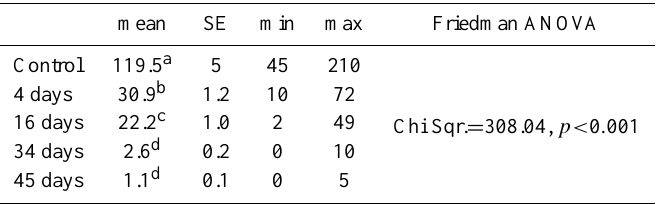
Table 1. Summary of Friedman ANOVA and Tukey HSD test, for ash thickness in a flat area in all measurement periods. Different letters mean significant differences at a p< 0 . 05. Data in mm. ( a = higher mean, d = lower mean ).